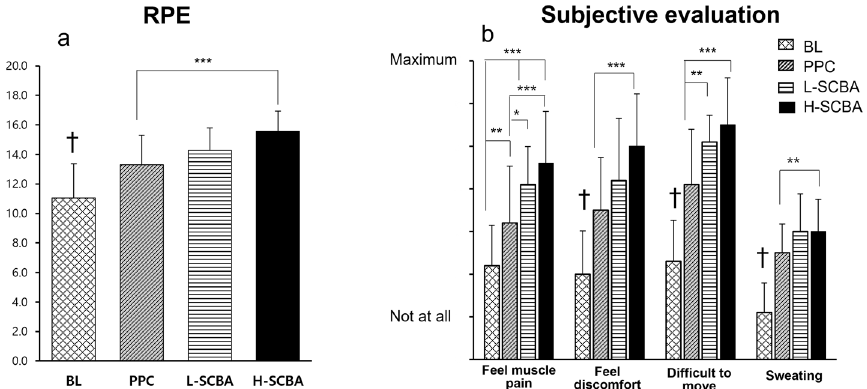
Fig. 3 Participants rated perceived exertion, and subjective evaluation in four personal protective equipment conditions. a Rated perceived exertion; b Muscle fatigue, discomfort, movement, and sweat sensation. Cross marks indicate statistically significant differences between baseline and PPE conditions (PPC, L‑SCBA, and H‑SCBA, p < 0.001). Asterisks indicate conditions showing statistically significant differences when